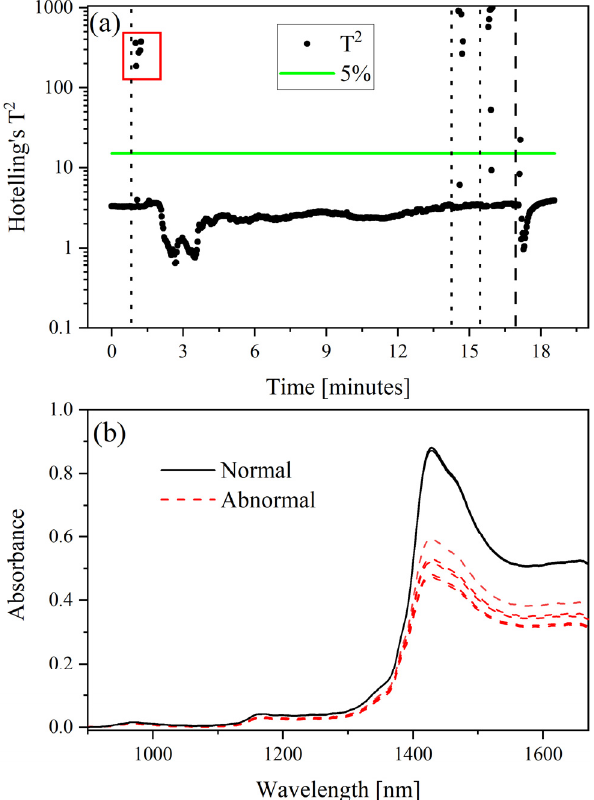
Figure 5. Acid gradient: ( a ) Hotelling’s T 2 statistic with (green line) p value 5% critical limit on a log 10 scale and ( b ) spectra representing normal and abnormal conditions during the time frame indicated by the red rectangle in ( a ). The vertical dotted lines indicate when air was intentionally introduced into the system, and the vertical dashed line indicates when the sample was switched back to 8 M HNO 3 .